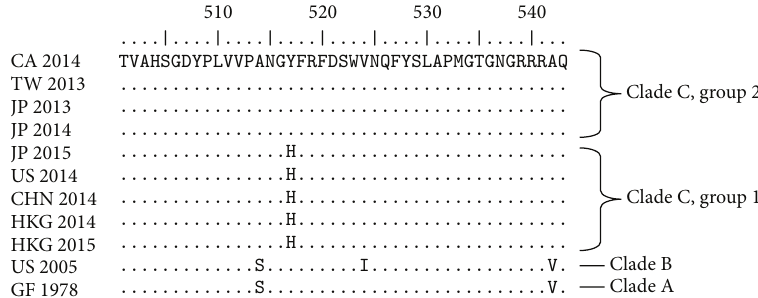
Figure 3: Multiple sequence alignment comparing the full length VP1 sequences of GII.P17-GII.17 noroviruses. Alignments were generated with BioEdit version 7.2.5. Genbank accession numbers, strain nomenclature, and abbreviations used in the figure are as follows: GII/Hu/CA/2014/GII.P17 GII.17/NS 065 (CA 2014); KJ156329, GII/Hu/TW/2013/GII.17/13BH1 (TW 2013); LC043168, GII/Hu/JP/2013/GII.17 GII.P17/Saitama5309 (JP 2013); AB983218, GII/Hu/JP/2014/GII.17 GII.P17/Kawasaki323 (JP 2014); KR083017,GII/Hu/US/2014/GII.17/Gaithersburg(US2014);KR020503,GII/Hu/CHN/2014/GII.17/41621/Guangzhou(CHN2014);KP998539, GII/Hu/HKG/2014/GII.17/CUHK-NS-463 (HKG 2014); KP698931, GII/Hu/HKG/2015/GII.17/CUHK-NS-513 (HKG 2015); LC037415, GII/ Hu/JP/2015/GII.P17 GII.17/Kawasaki308 (JP 2015); DQ438972, GII/Hu/US/2005/NoV/Katrina-17 (US 2005); JN699043, GII/Hu/GF/1978/ GII.17/C142 (GF